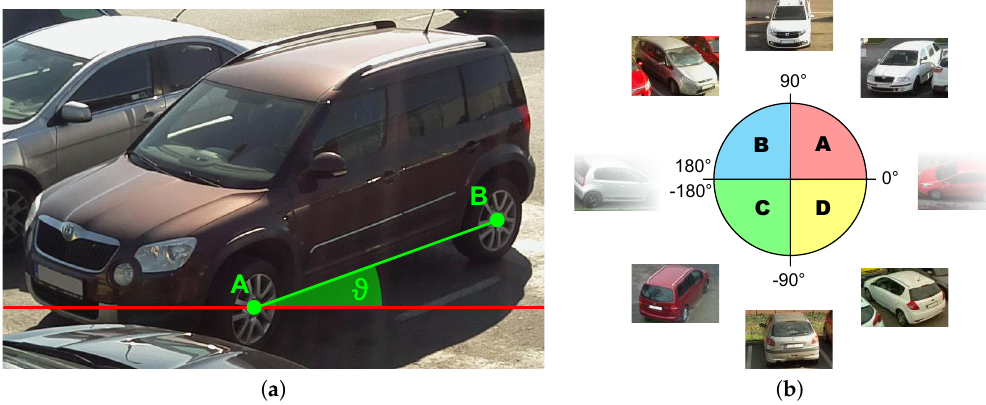
Figure 3. Orientation of the vehicle in the sample. ( a ) Example of the training sample with manually labeled wheels. ( b ) Demonstration of the similarity of differently rotated vehicles.